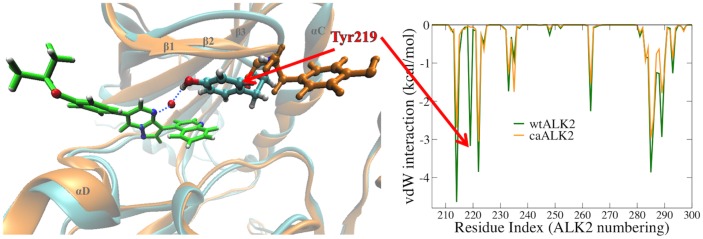

Left: Superposition of wtALK2 (cyan) and caALK2 (orange) backbone in cartoon. P-loop Tyr219 is shown in sticks. The ligand DMH1 is shown in light green. Tyr219 in caALK2 (orange) is pointing away from DMH1. Tyr219 in wtALK2 (cyan) is pointing towards the ligand and forms a water-mediated hydrogen bond with N4 on the pyrimidine moiety of DMH1. Right: van der Waals interaction energies in kcal/mol between each ALK2 residues and DMH1: wtALK2 in green, caALK2 in orange.